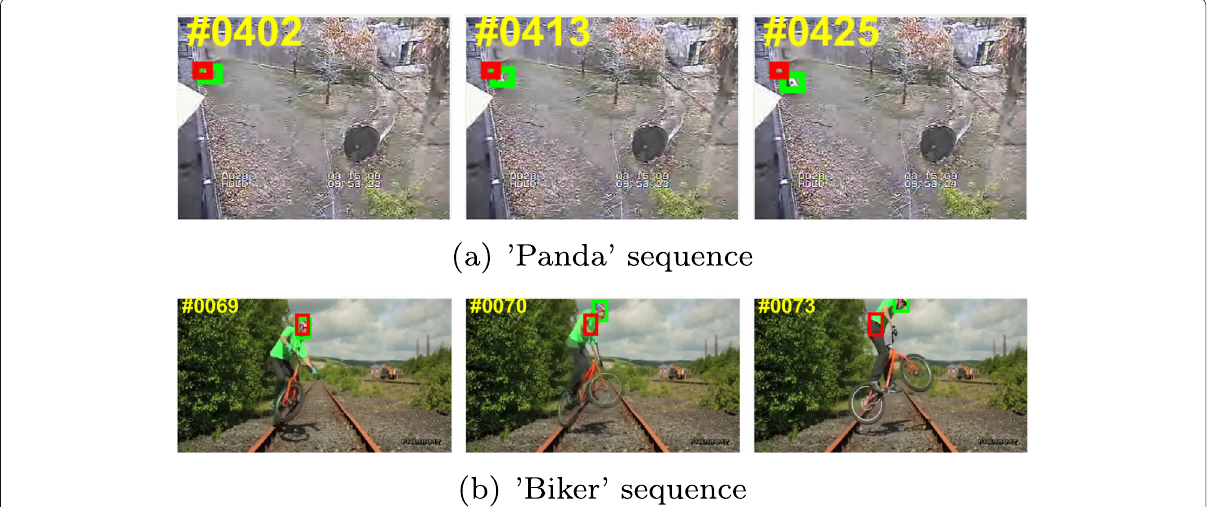
Fig. 10 Failure cases. Red and green boxes represent tracking results and ground truth, respectively. a “Panda” sequence. b “Biker”